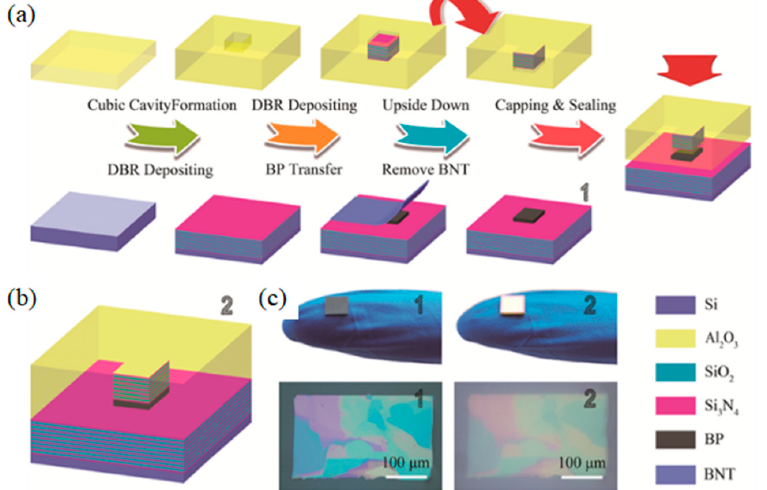
Figure 5. ( a ) Manufacturing process of BP laser is designed with an open cavity surface emitting laser device. Using sapphire as the substrate, DBR is deposited in the cubic step hole, bonding the substrate reverse. After preparing the steps for DBR deposition on the silicon substrate and bottom assembly, transfer the Nitto tape with blue Nitto tape, and finally combine them to obtain the laser device. ( b ) Schematic diagram of the completed laser device. ( c ) The image on the left shows the BP film covering the waveguide and the optical micrograph, while the image on the right shows the final image and the optical micrograph of the device [211]. Copyright 2019 American Chemical So- ciety.